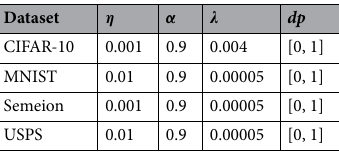
Table 6. The CNN η , α and (cid:31) adjustments for simulations.